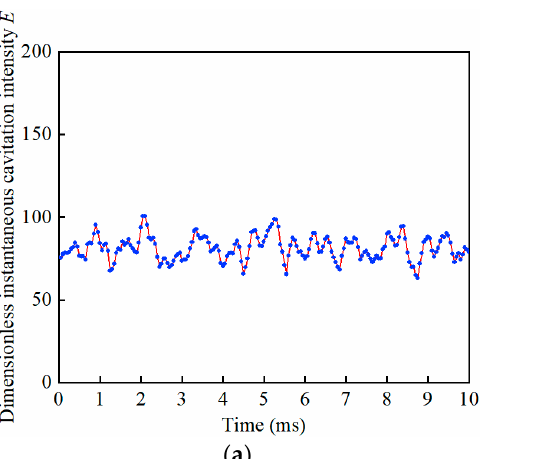
Figure 9. Mass loss of the sample: ( a ) at a working pressure of 10 MPa; ( b ) at a working pressure of 15 MPa.